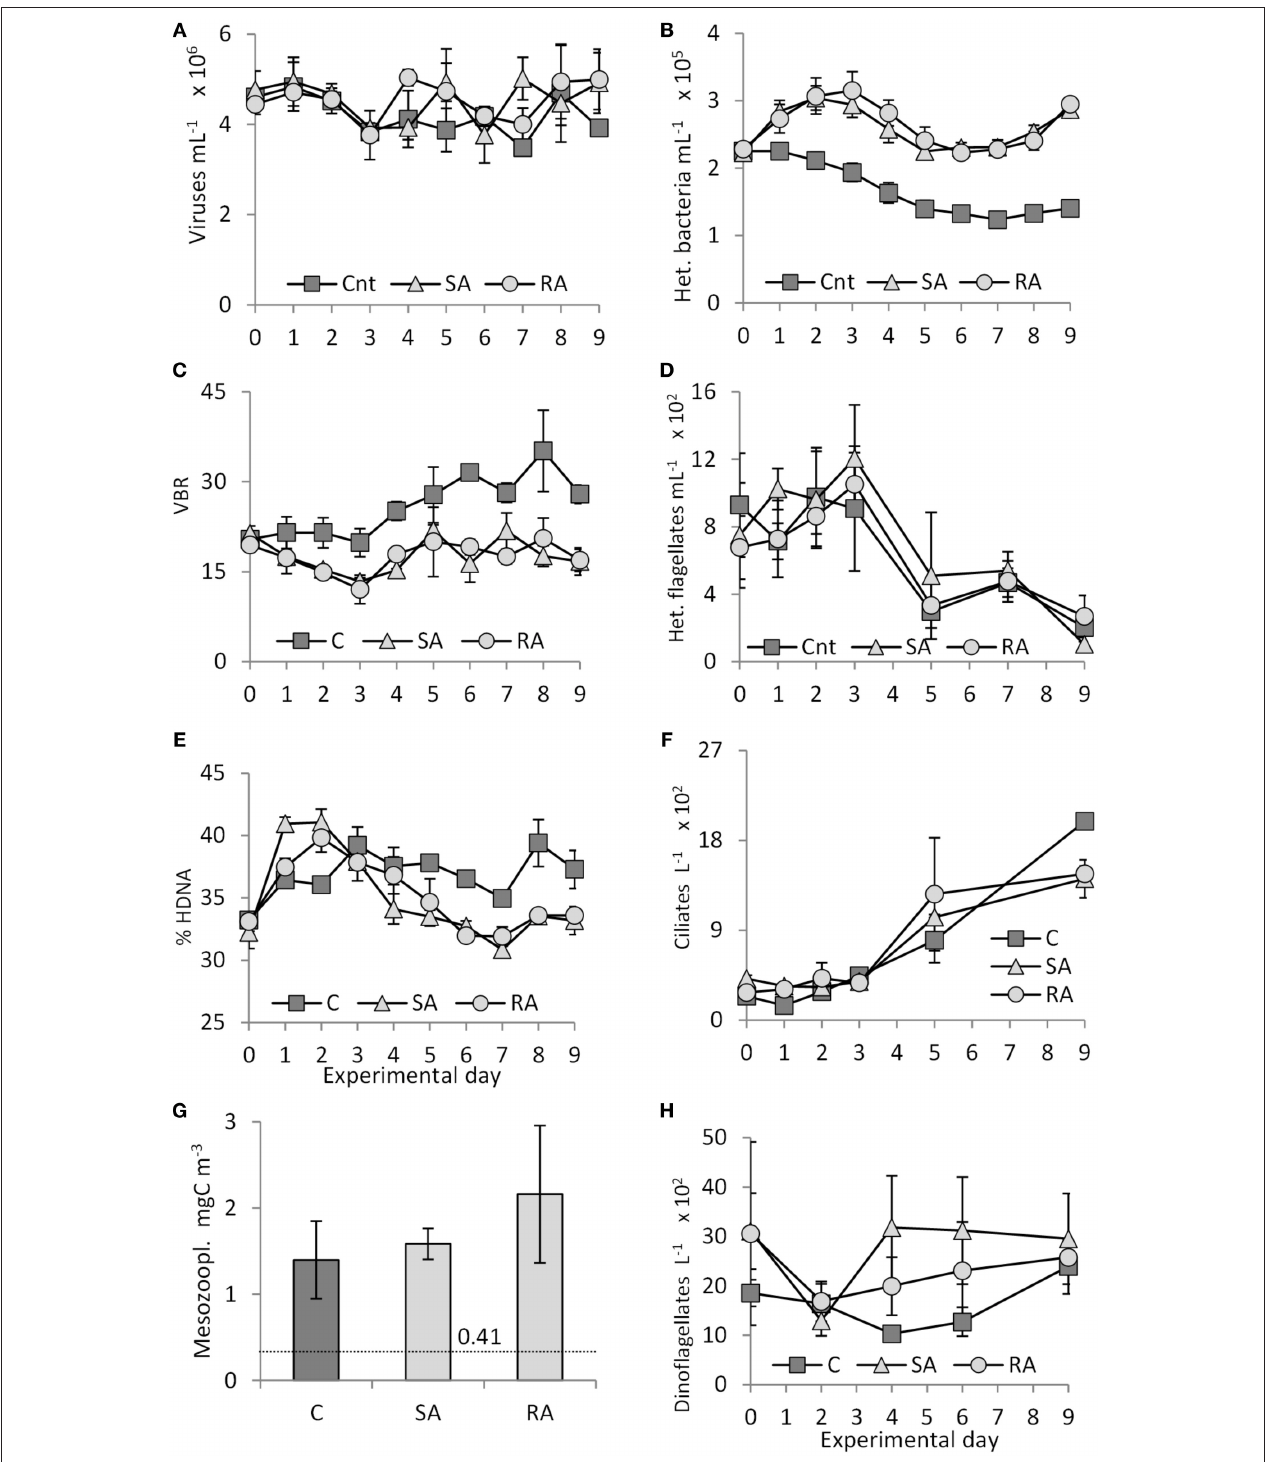
FIGURE 7 | (A) Virus abundance, (B) heterotrophic bacterial abundance, (C) Virus to bacteria ratio (VBR), (D) heterotrophic flagellate abundance, (E) percentage of High DNA bacteria (HDNA), (F) ciliate abundance, (G) mesozooplankton biomass on the last day of the experiment (dashed line indicates mesozooplankton biomass (0.41 mgC m − 3 ) in the field, at the start of the experiment), and (H) dinoflagellate abundance during the mesocosm experiment. Cnt = Control mesocosms (no addition), SA = single addition, mesocosms where dust was added once, on the first day of the experiment, RA = repetitive addition, mesocosms where the same quantity of dust was added, divided into three doses, on the first 3 days of the experiment, Days 0, 1, and 2. Data are mean ± SD of three replicates.